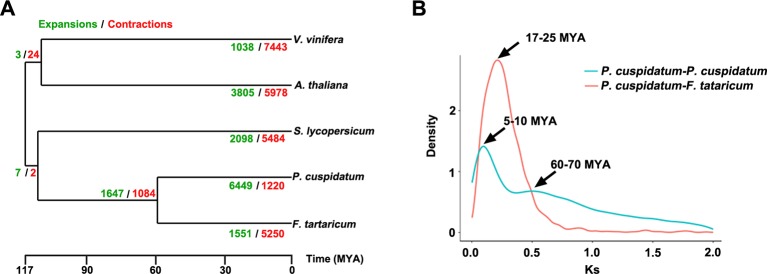
Dynamic evolution of gene families. (A) Gene family expansion and contraction in five plants species. The gene families that have undergone expansion and contraction are shown in green and red, respectively. The numbers separated by slashes (expansions/contractions) indicate the number of gene families. The scale bar indicates the divergence time [million years ago (MYA)]. (B) Ks distribution of paralogous gene pairs in P. cuspidatum and F. tataricum. In this analysis, two peaks were identified, which are thought to represent two WGD events. The x-axis shows Ks values, and the y-axis shows the density of distribution.